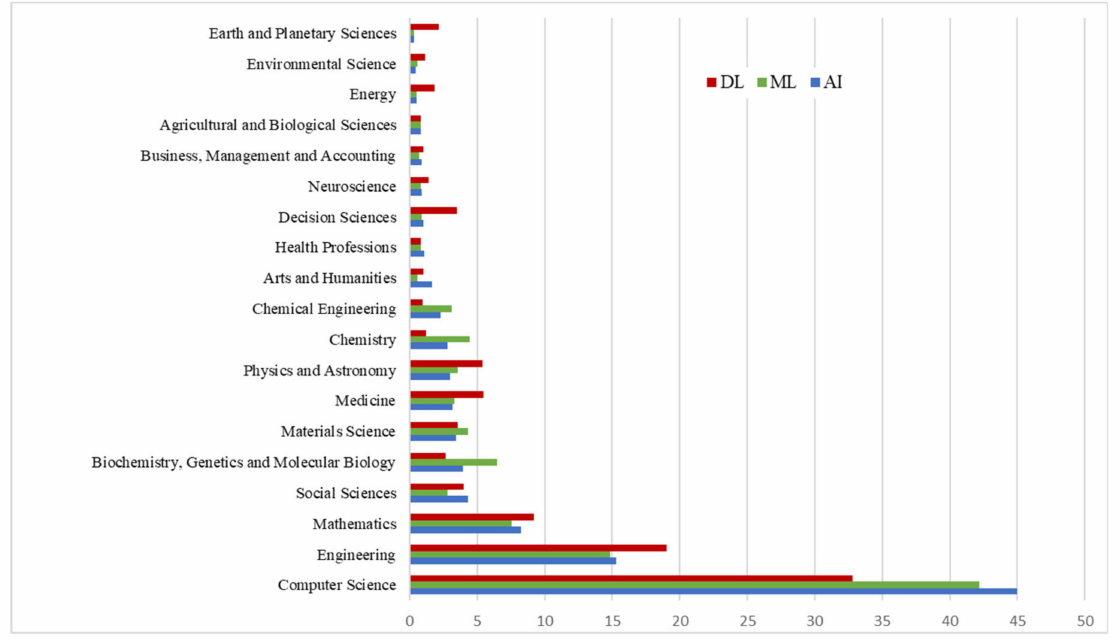
Figure 2. Ranking of the reviews in Scopus according to the areas of application (percentage). Source: generated by the